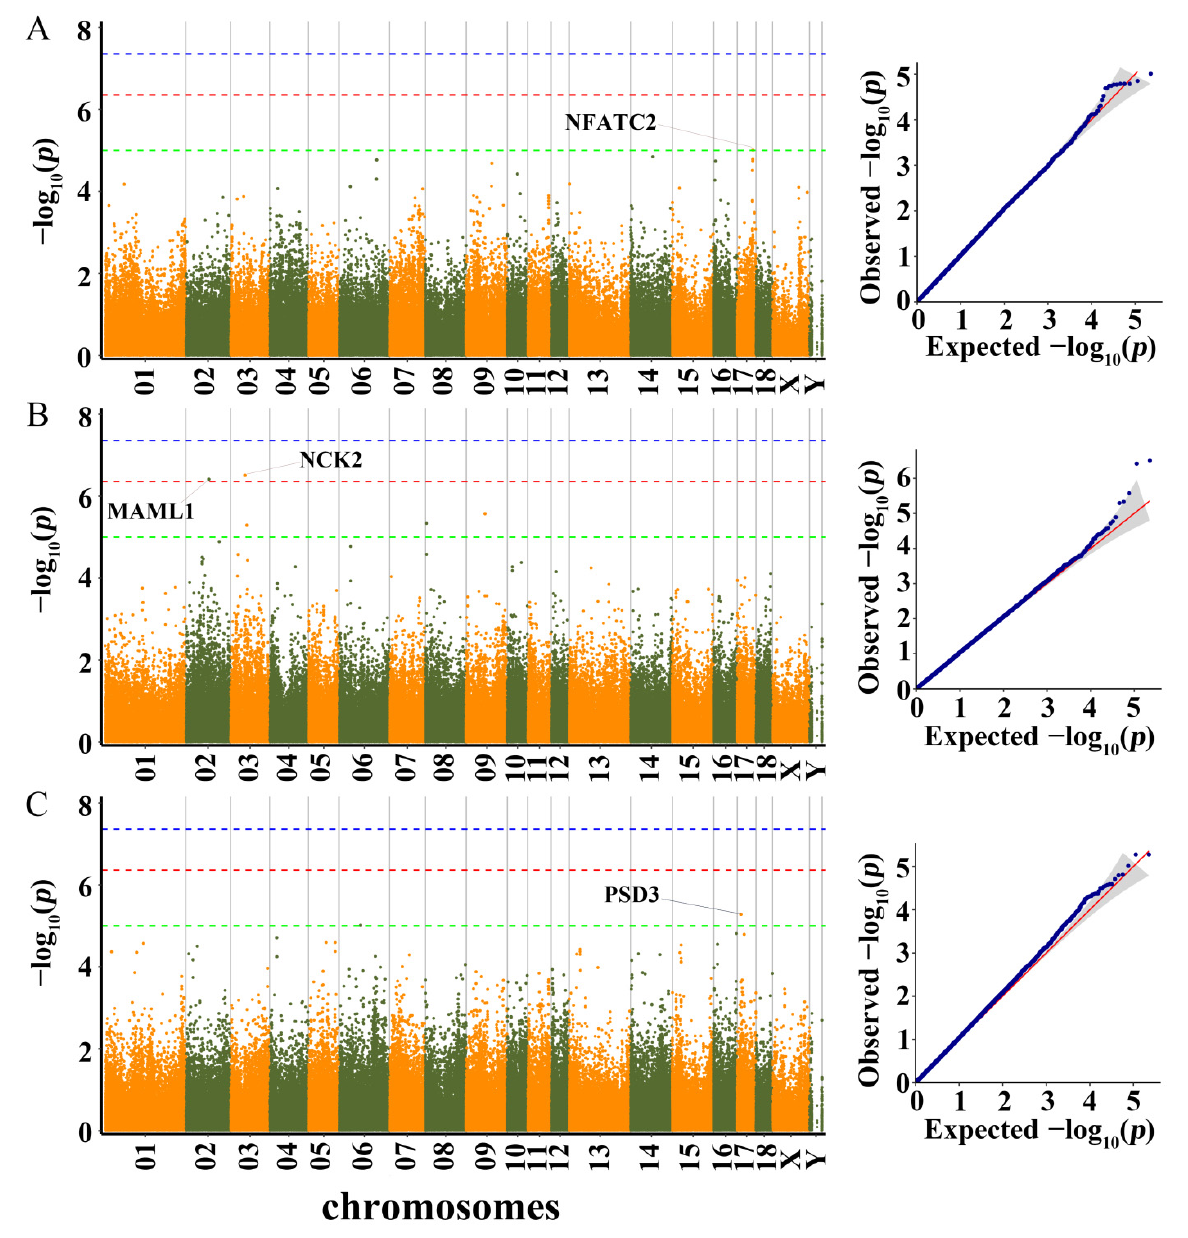
Figure 5. Manhattan plots and QQ plots for CC, CD and RC using MLM. ( A ) CC, ( B ) CD, ( C ) RC. Negative log 10 p -values of the filtered high-quality SNPs were plotted against their genomic posi- tions. The dashed lines of green, orange and blue correspond to the Bonferroni-corrected thresholds of p = 1.00 × 10 − 5 ( − log 10 p = 5), p = 4.39 × 10 − 7 ( − log 10 p = 6.36) and p = 4.39 × 10 − 8 ( − log 10 p = 7.36), respectively.